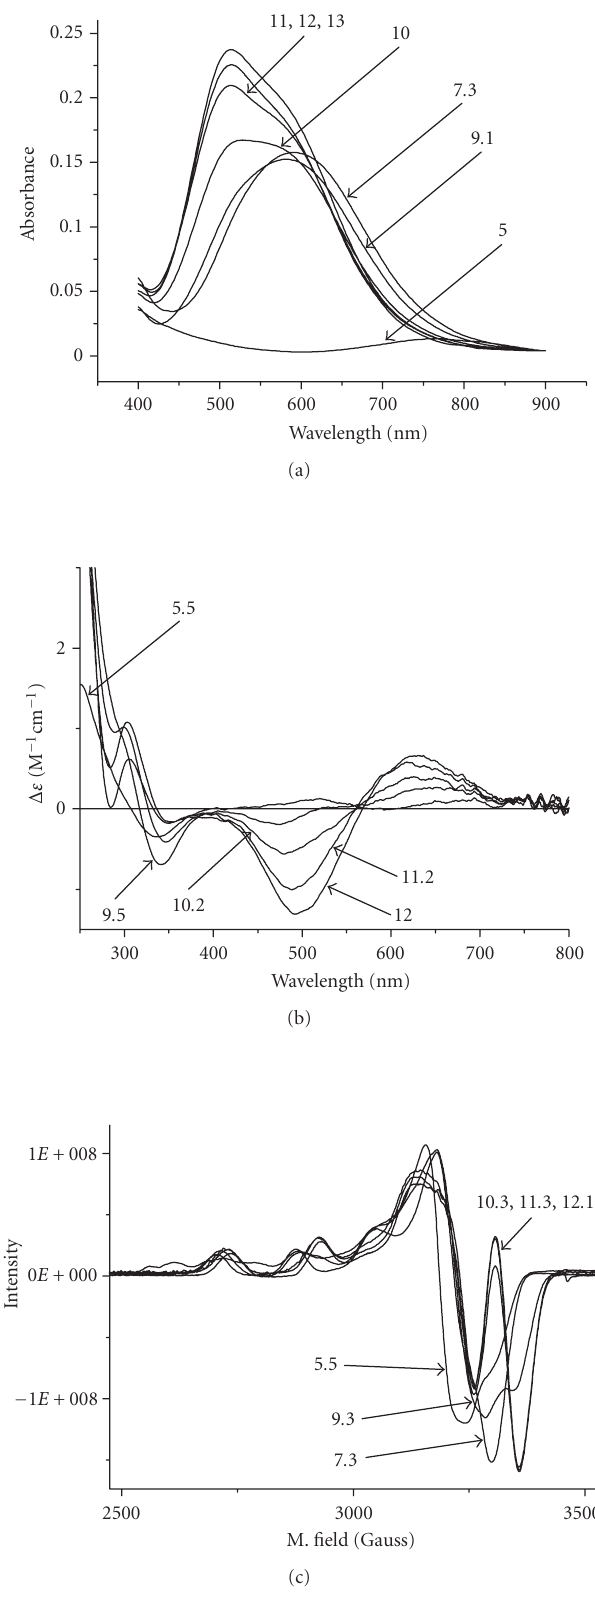
Figure 2: (a) UV/Vis, (b) CD and (c) EPR spectra of the system Cu(II)/-LAHYNK- (1 : 1) at various pH